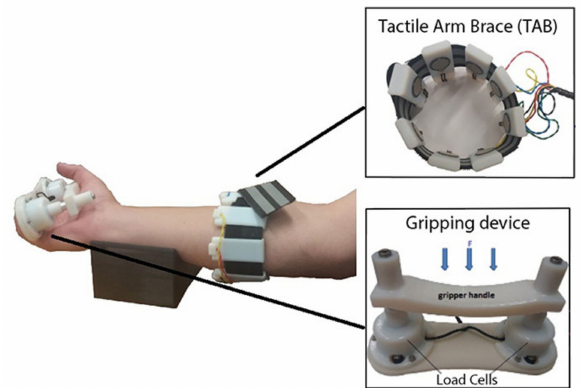
Figure 6. An example of FMG device with an array of eight force sensors (Tactile Arm Brace) placed on the able-bodied user. Adapted from [101], licensed under CC BY